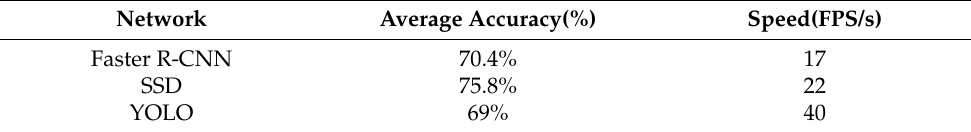
Table 1. Comparison of Deep Learning Object Detection Network Effects.